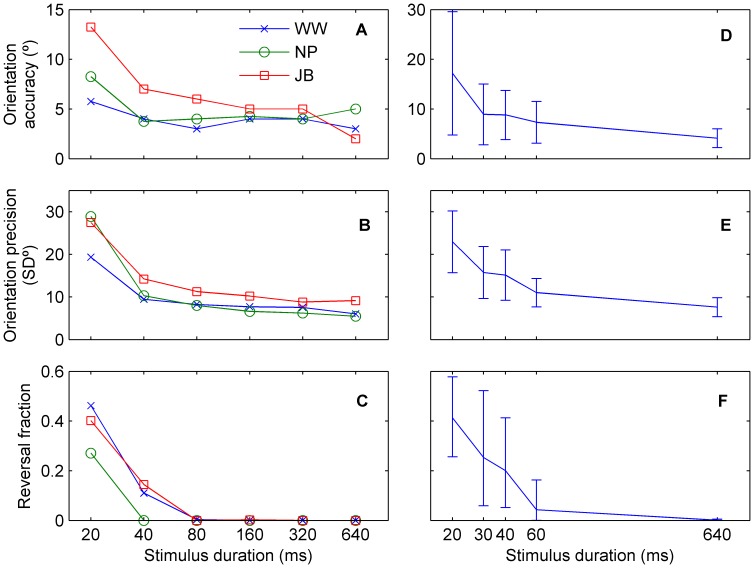
Duration-dependent perceptual performance.Increasing stimulus duration leads to better orientation accuracy (A, D), better orientation precision (B, E) and fewer reversals (C, F). Individual results are shown for three experienced observers (A–C) and for eleven participants (mean ± SD) tested over a different set of duration conditions (D–F).